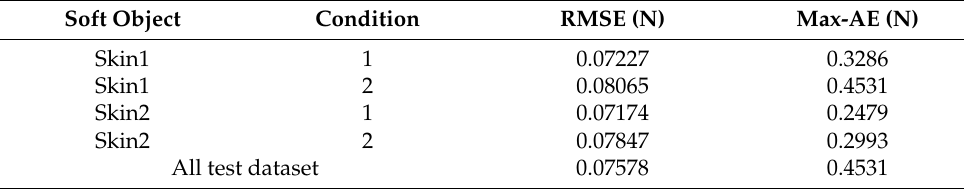
Figure 6. The estimated tensile force estimation results from the proposed network for two soft objects and two conditions: ( a ) Graph from 85° view for Skin1, Condition1, ( b ) graph from 70° view for Skin1, Condition 2, ( c ) graph from 55° view for Skin2, Condition1, and ( d ) graph from 40° view for Skin2, Condition 2. Sixty time steps are equal to 1 s. Table 1. Results comparison for two objects and two conditions for untrained